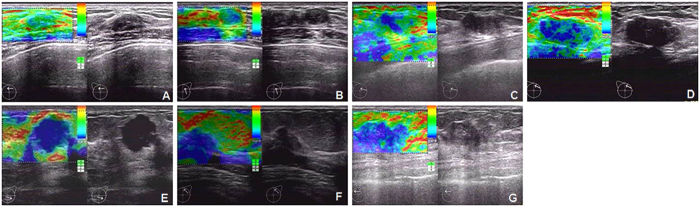
Representative pictures for the USE diagnosis (7-point elasticity scoring) of benign and malignant breast lesions.Scores <5 were classified as benign lesions, whereas scores ≥5 were classified as malignant lesions. (A) Elastosonography shows uniformed green (Score 1). Pathologic result: benign. (B) Elastosonography shows blue and green mosaic. Main color is green (Score 2). Pathologic result: benign. (C) Elastosonography shows center blue with green surrounding (Score 3). Pathologic result: benign. (D) Elastosonography shows blue and green mosaic. Main color is blue (Score 4). Pathologic result: benign. (E) Elastosonography shows lump was covered in blue area. (Score 5). Pathologic result: infiltrating ductal carcinoma. (F) Elastosonography shows lump its below was covered in blue area (Score 6). Pathologic result: infiltrating ductal carcinoma. (G) Elastosonography shows lump its surrounding was covered in blue area. Blue area is bigger than lump area (Score 7). Pathologic result: infiltrating ductal carcinoma.